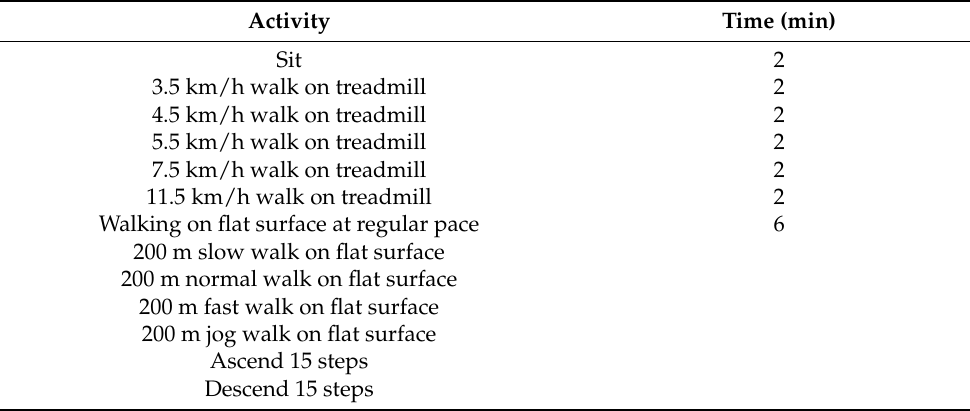
Table 1. Supervised protocol